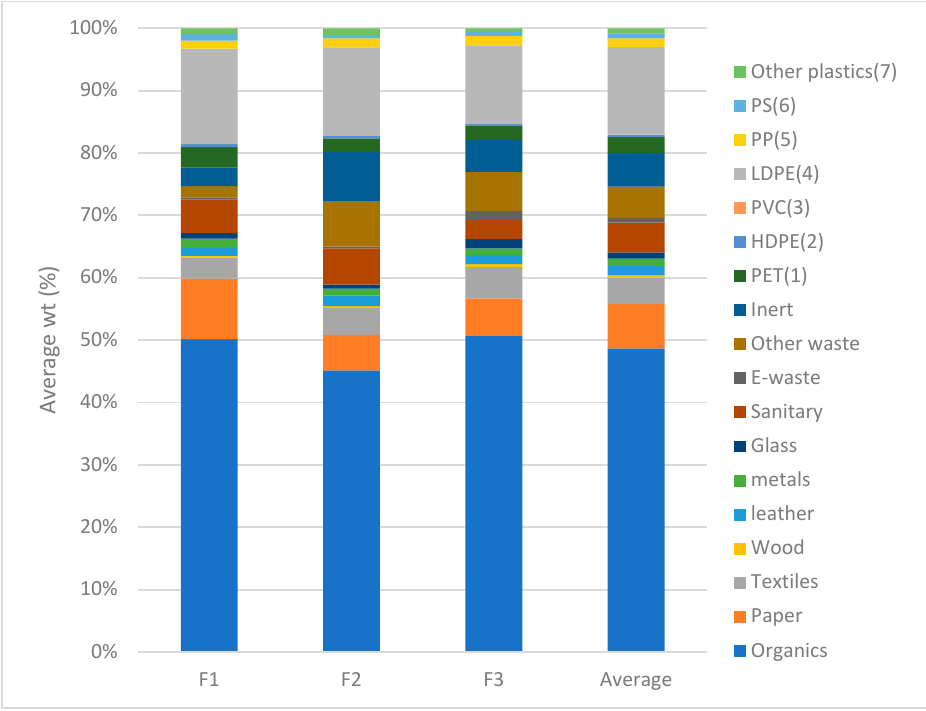
Figure 3. Composition of MSW received at the MRFs.